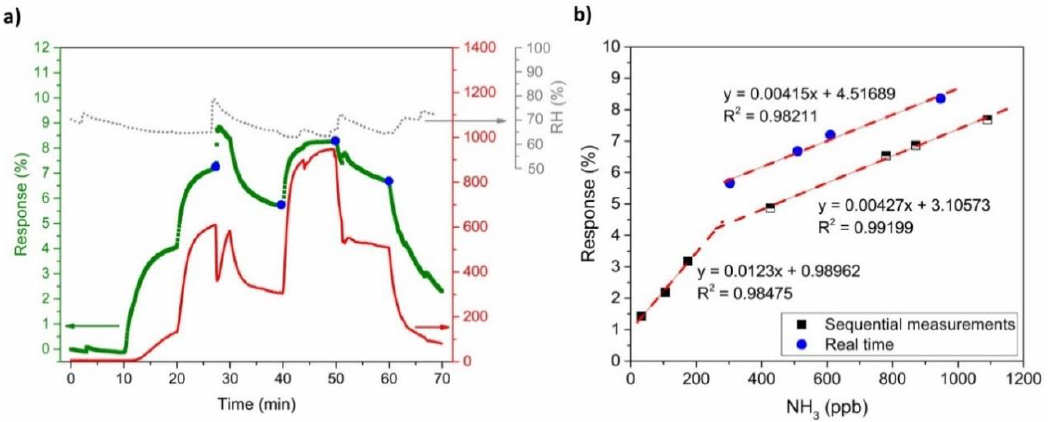
Figure 12. ( a ) PANI-Au-SPE sensor’s response, NH 3 concentration, and RH vs. time—simulation of real-time measurement and ( b ) comparison of PANI-Au-SPE sensor’s responses obtained from real-time measurement with the calibration curve.